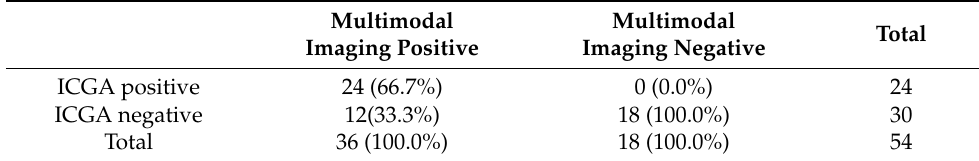
ICGA: Indocyanine green angiography.